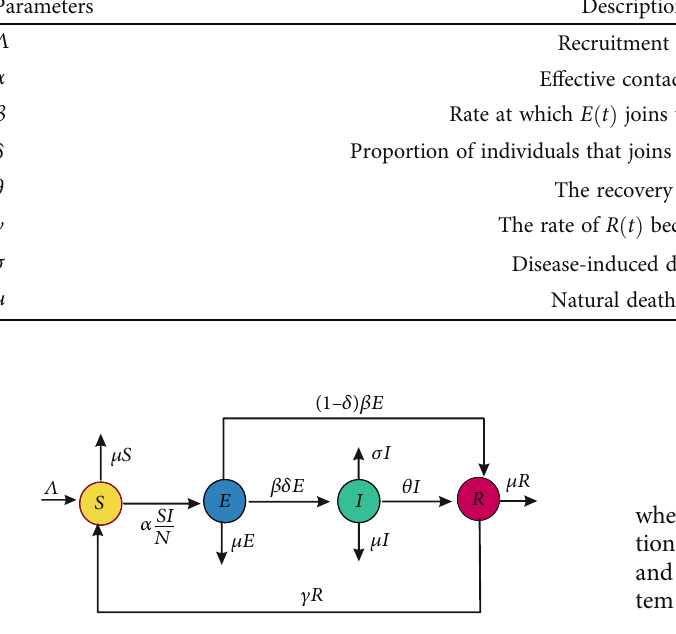
Figure 1: Flow chart of the